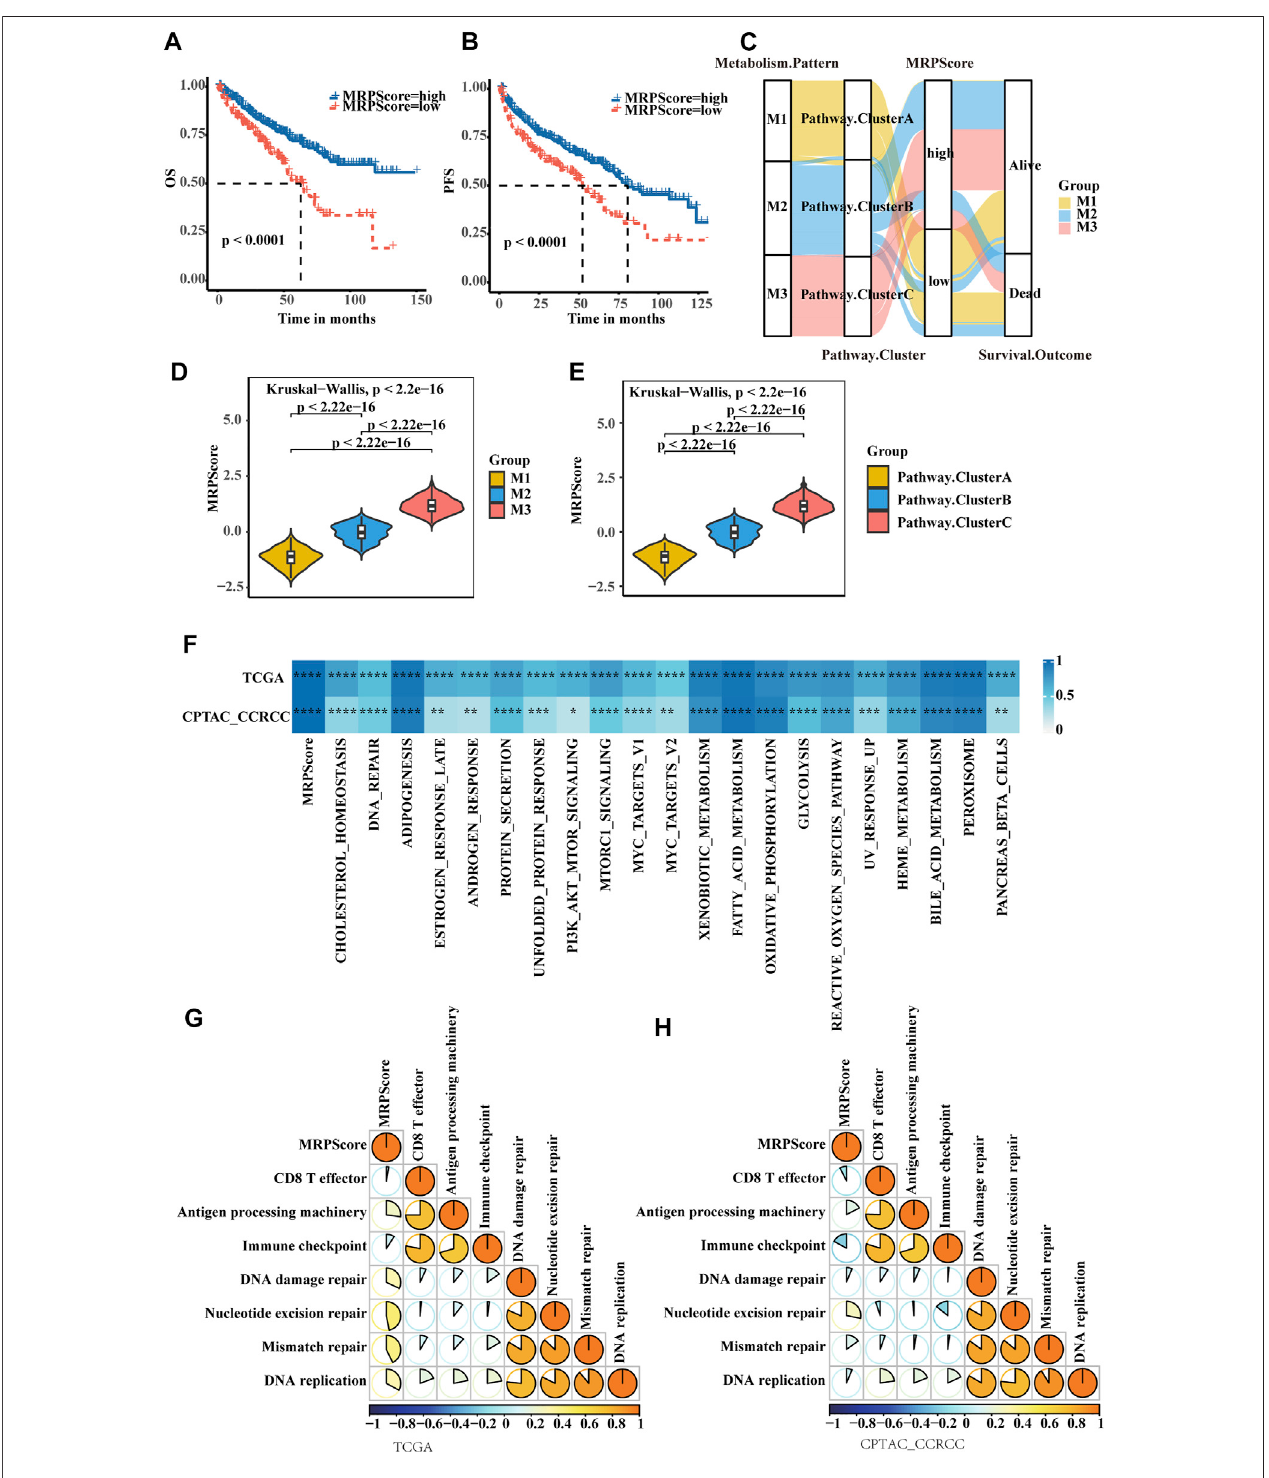
FIGURE4| Quanti fi cationofmetabolicsignaturesbasedontheMRPScoreintheTCGA-KIRCcohort. (A) OSanalysesforhigh-andlow-MRPScorepatientgroups in the TCGA-KIRC cohort using Kaplan-Meier curves. (B) PFS survival analyses for high- and low-MRPScore patient groups in the TCGA-KIRC cohort using Kaplan- Meier curves. (C) Alluvial diagram of the metabolic patterns in groups with different pathway clusters, MRPScores, and survival outcomes. (D) Differences in the MRPScores among the three metabolic patterns in the TCGA-KIRC cohort. The Kruskal – Wallis test was used to compare the signi fi cant differences between the three metabolic patterns. (E) Differences in the MRPScores among the three pathway clusters in the TCGA-KIRC cohort. The Kruskal – Wallis test was used to compare